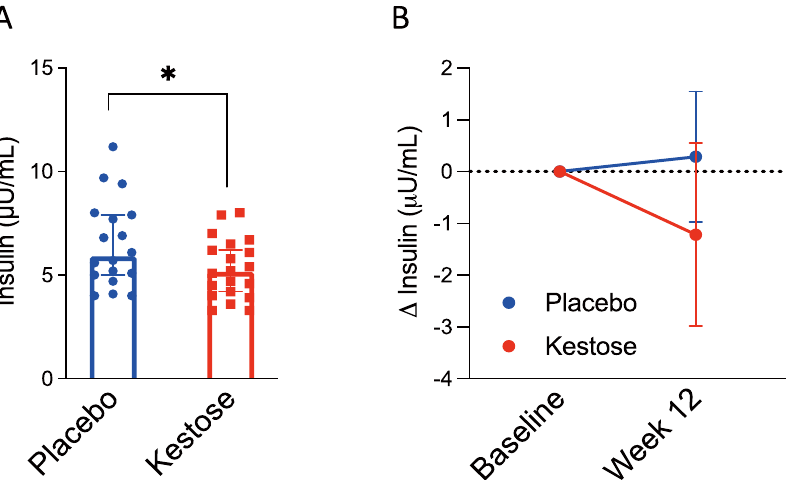
Figure 2. Fasting serum insulin level was lower in the kestose group compared to the placebo group. ( A ): Fasting serum insulin concentration was measured after the 12-week intervention with or without 1-kestose. ( B ): Differences of insulin concentrations during the 12-week intervention with 95% CI were calculated. Abbreviations: CI, confidence interval. A and B were assessed for statistical significance using Student’s t-test. * p <